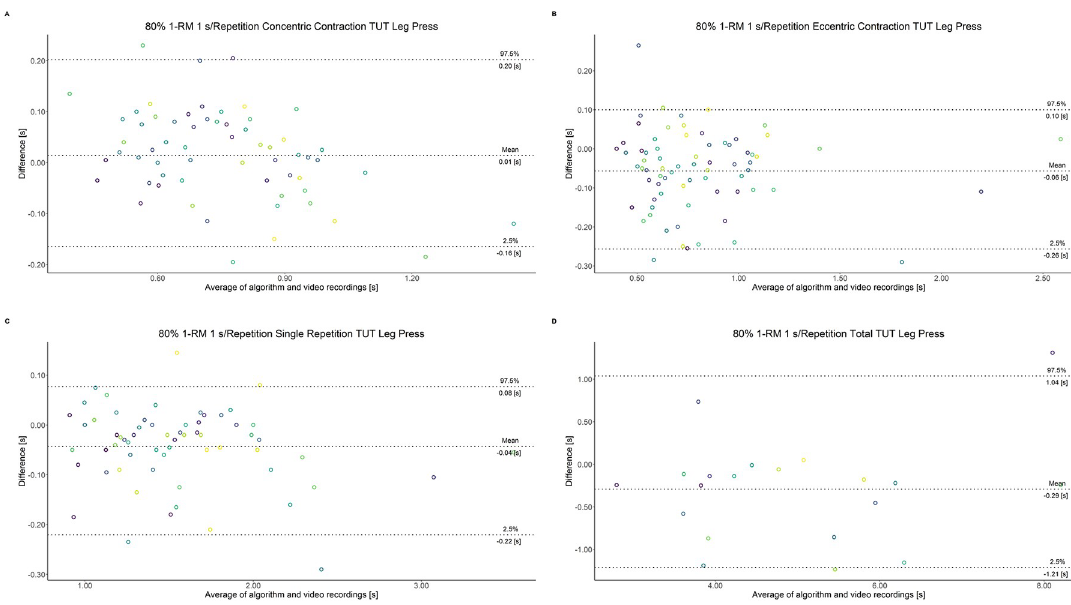
Fig 15. Bland-Altman plots of agreement between algorithmically accelerometer derived and video recordings derived contraction-specific phases of the leg press machine at 80% 1-RM with a velocity of 1 s per repetition. A: Concentric contraction phase. B: Eccentric contraction phase. C: Single repetition. D: Total time-under-tension.